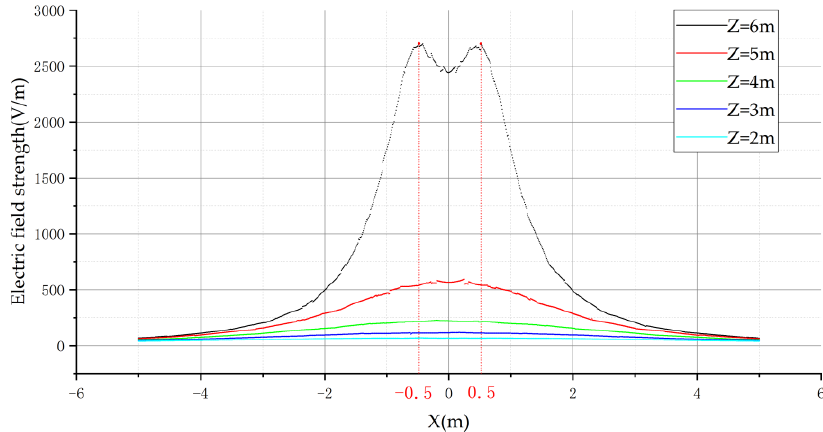
Figure 11. Electric field distribution in triangular arrangement. The three-phase transmission line in triangular arrangement is also symmetrically distributed on the left and right axis of symmetry with the center wire, and the electric field distribution of the horizontal arrangement is the same in the center wire side of the electric field variation is not monotonic. In the region of X < − 0.5 and X > 0.5, the variation of electric field intensity satisfies monotonicity. Therefore, for the triangular arrangement, the flight area of the UAV is equally to the left of the A-phase transmission line or to the right of the C-phase transmission line. lar arrangement was analyzed and the curves obtained are shown in Figure 12 below.